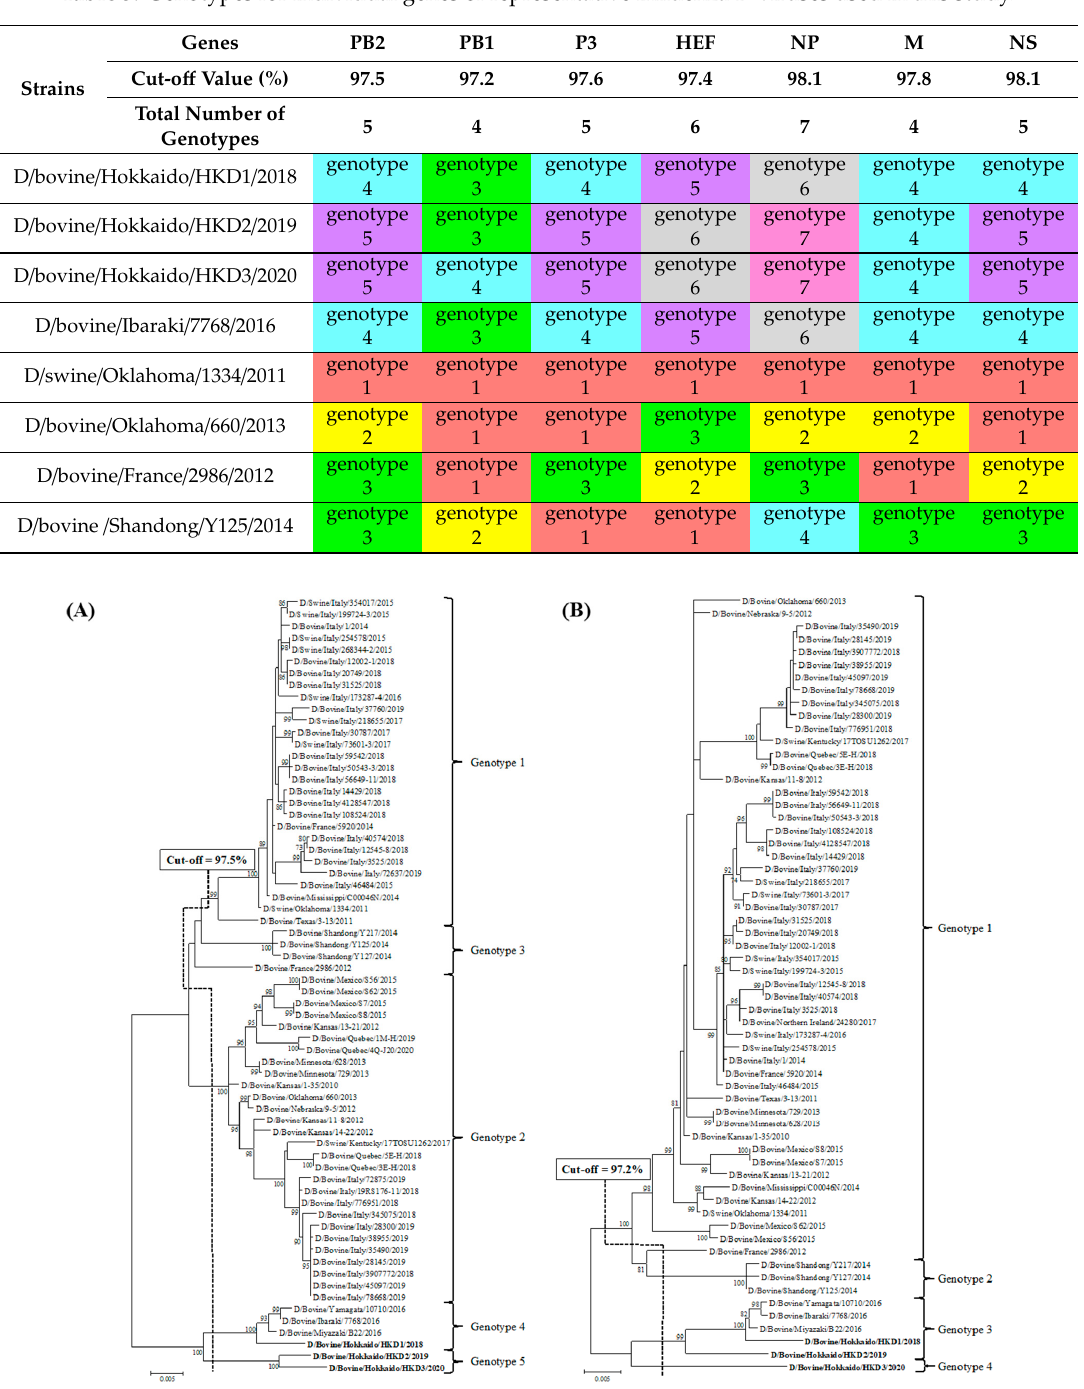
Table 3. Genotypes for individual genes of representative influenza D viruses used in this study.